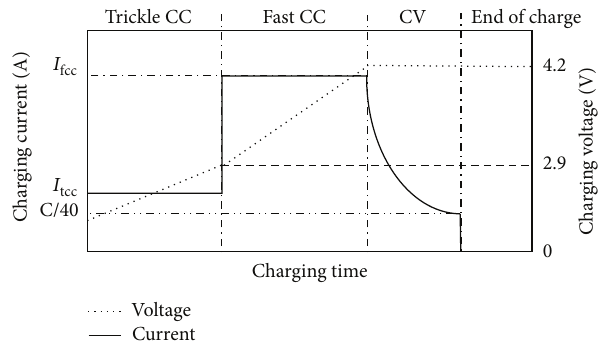
Figure 1: Typical charging process of a Li-ion battery.